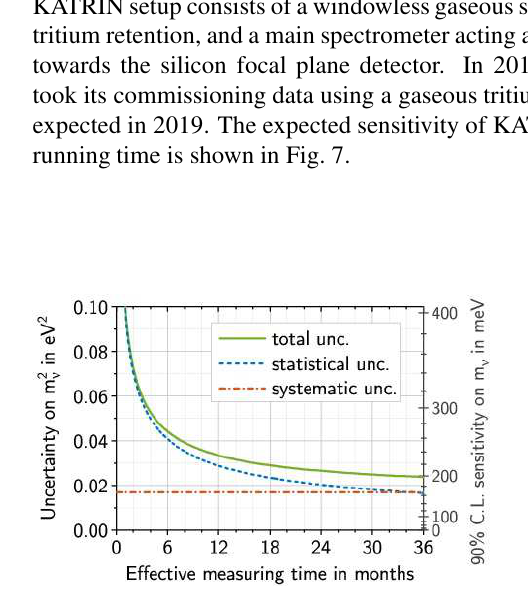
Figure 8. Upper limits (90% CL) on the e ff ec- tive mass < m ββ > from recent 0 ν 2 β search ex- periments and the allowed regions for the nor- mal mass hierarchy (NH), the inverted mass hierarchy (IH) and the quasi-degenerated re- gions provided by the neutrino oscillation ex-